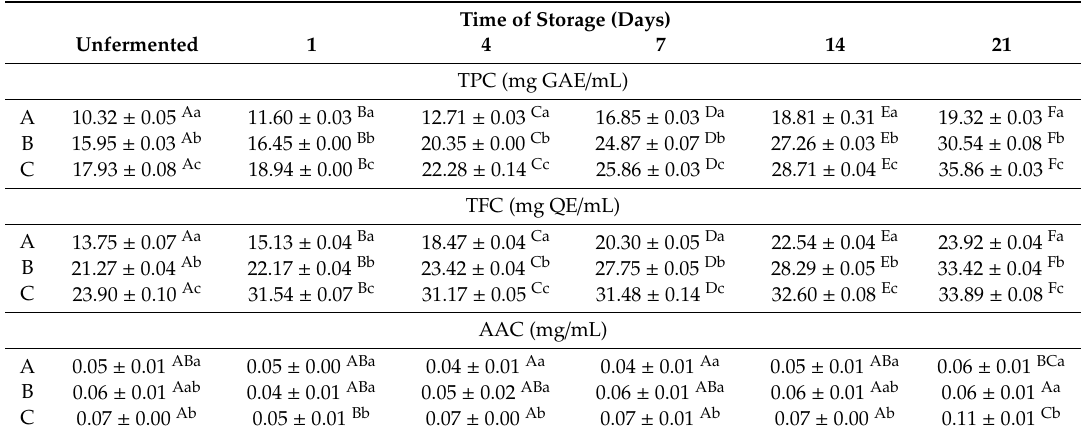
Table 2. Total polyphenolics content (TPC), total flavonoids content (TFC), and ascorbic acid content (AAC) changes of the samples during storage. Time of Storage